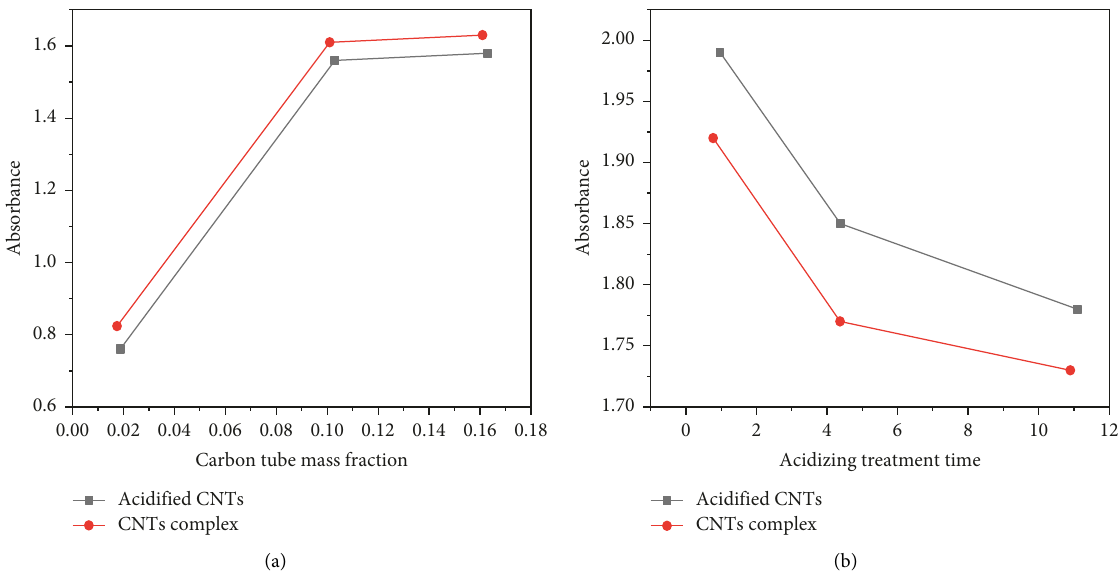
Figure 5: (a) Influence of carbon tube concentration. (b) Acidizing